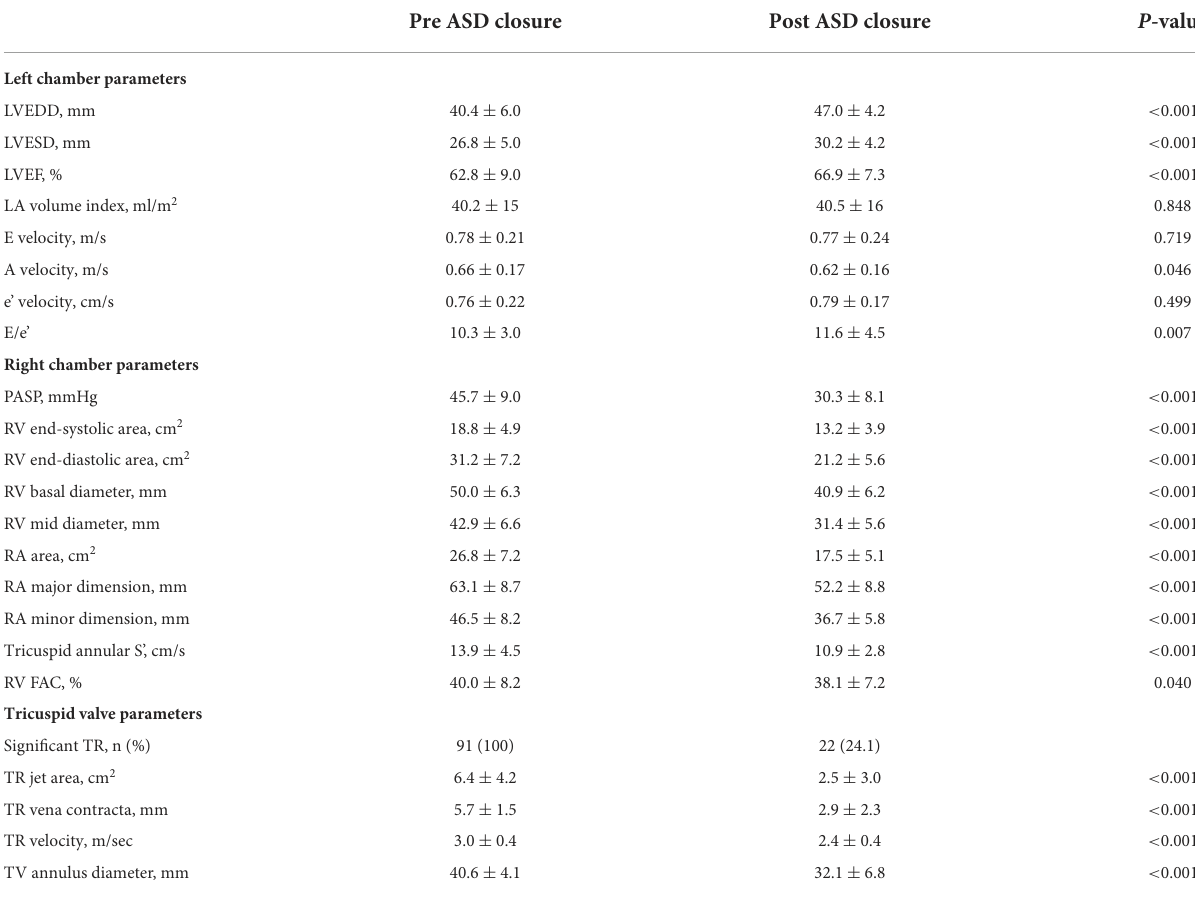
TABLE 2 Echocardiographic parameters before and after ASD